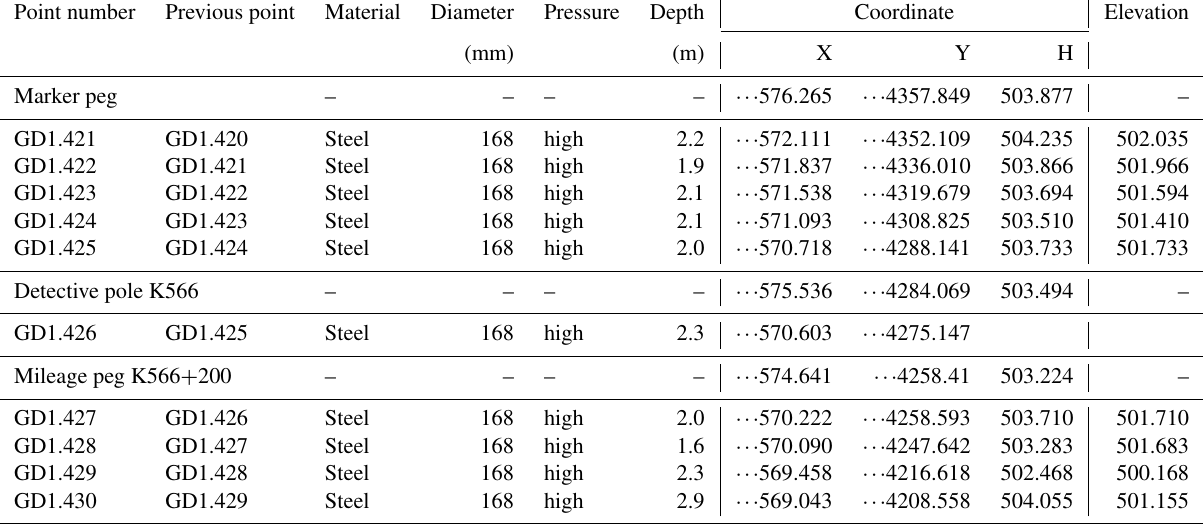
Table D1. Coordinates of the centerline and ancillary facilities of the pipeline. Secrecy regulations regarding geographical coordinate data in the People’s Republic of China stipulate that the first three digits of each location’s coordinates remain confidential. In this table, this has been represented by